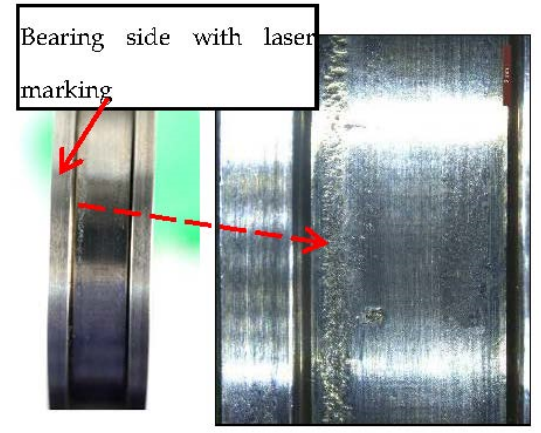
Figure 8. Macroscopic morphologies of the spalling position of the inner ring raceway.